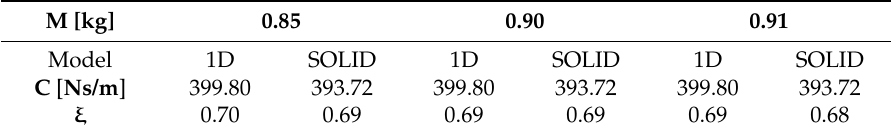
Table 10. Damping coefficients and damping rotations for the three speeds considered for the analytical model and the FE model.